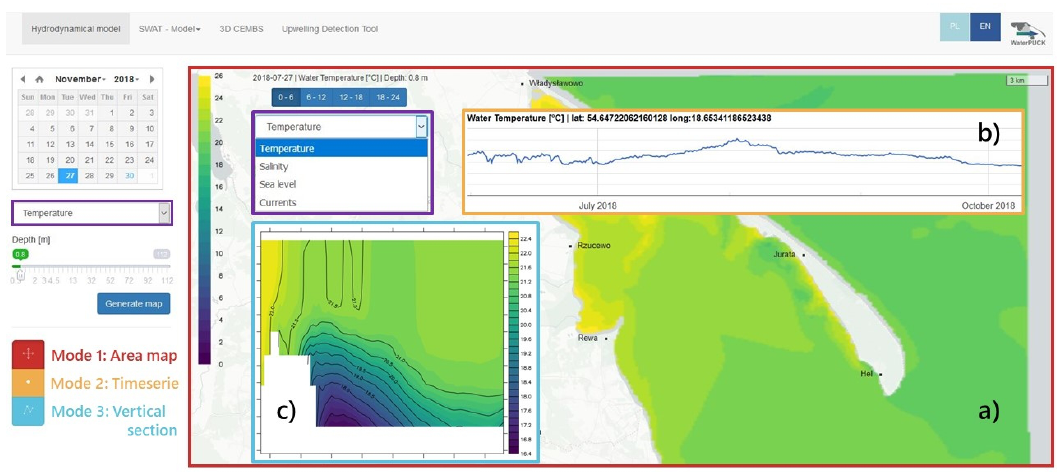
Figure 16. Screenshot of navigation menu and results for the Web Portal service ( a ) raster map ( b ) time series ( c ) vertical cross-section of selected